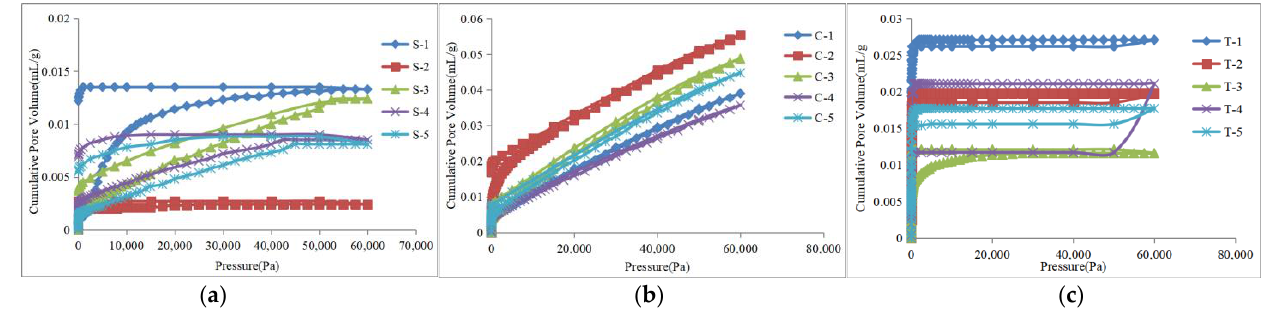
Figure 10. Mercury injection–withdraw curves of shale, coal, and tight sandstone samples. ( a ) Shale samples. ( b ) Coal samples. ( c ) Tight sandstone samples.